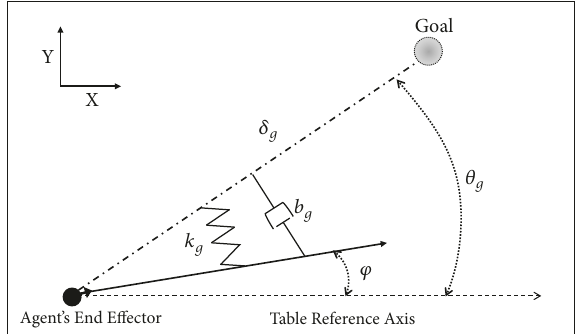
Figure 1: Illustration of the dynamical task space adapted from [10]. The goal is the object to be picked up or the location to place the objectdepending on the subtask phase. The model predicts a change in the agent’s end-effector heading, 𝜑 , such that 𝜑 ≈ 𝜃 𝑔 . The rate of change of 𝜑 depends on the values of 𝑘 𝑔 and 𝑏 𝑔 along with the distance to the goal, 𝑑 𝑔